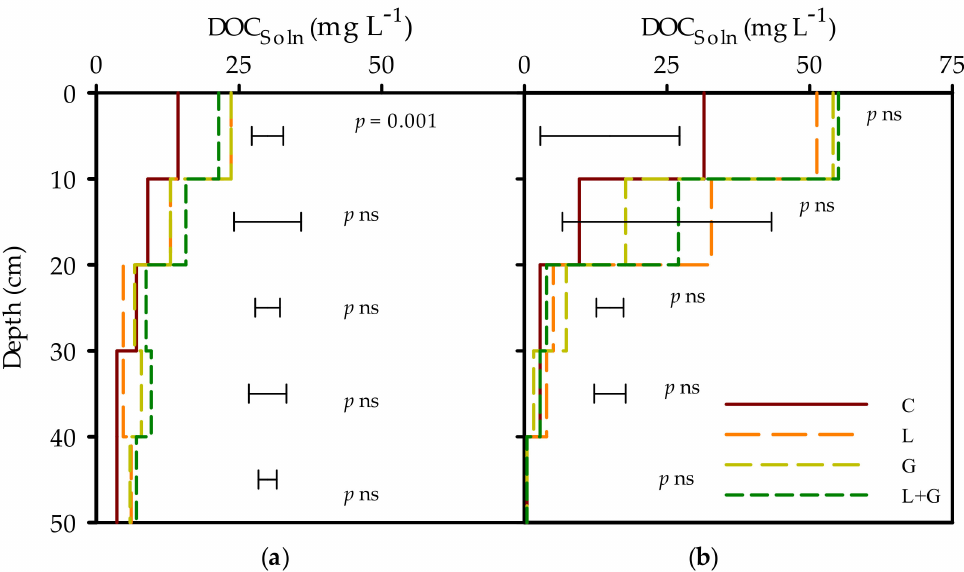
Figure 3. ( a ) The soil solution dissolved organic carbon (DOC Soln ) (mg L − 1 ) in the ST ( b ) and LT for the C, L, G, and L + G treatments. The error bars represent the least significant difference values at p = 0.05, n = 3 for each depth with ns denoting p > 0.05.